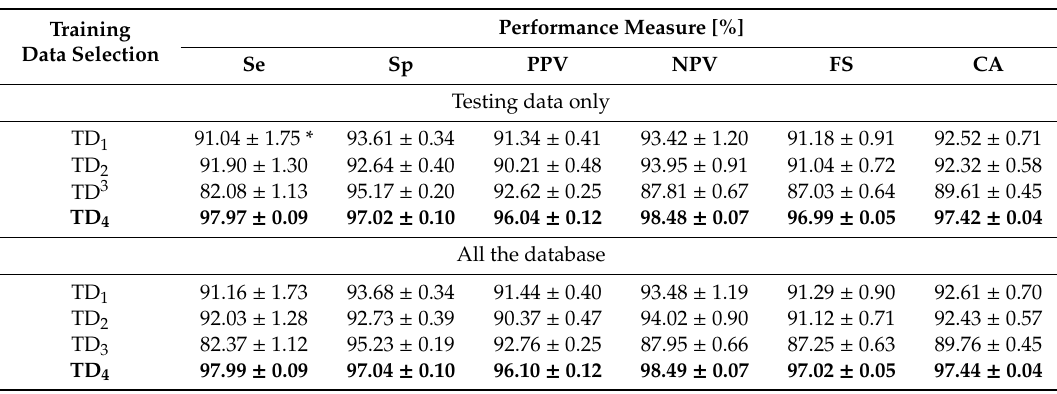
Table 4. The results of MIT-BIH AF database evaluation when FHR variability features were excluded from recognition of the AF episodes. The LSVM classifier ( γ = 10, χ = 4 ) was trained with the balanced dataset ( N TRN = 17 000), extracted from: the signal of highest FS (TD 1 ), mixed signals of the highest Se and FS (TD 2 ), mixed signals that were characterized by the highest Se, Sp and FS (TD 3 ), and all the signals (TD 4 ). The best results obtained for testing data only and for all data are in